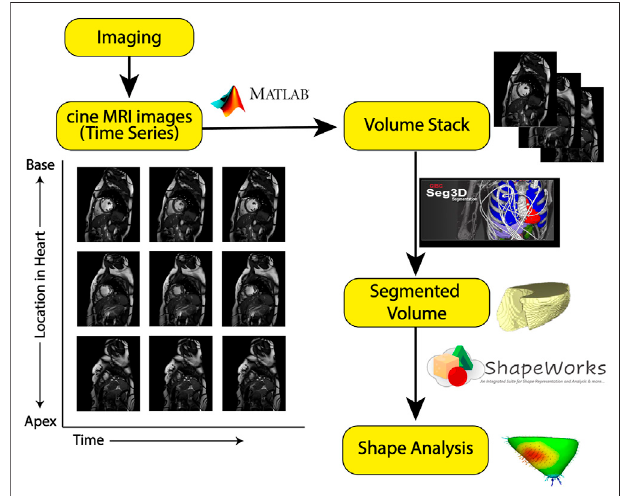
FIGURE2| Imageprocessingpipeline:Theyellowboxesrepresenteach step in the processing pipeline. The symbols along the arrows show the software tool used to go from one step to another. From cine-MRI images, volume stacks were created and segmented using Seg3D, then uploaded to ShapeWorks for particle-based shape